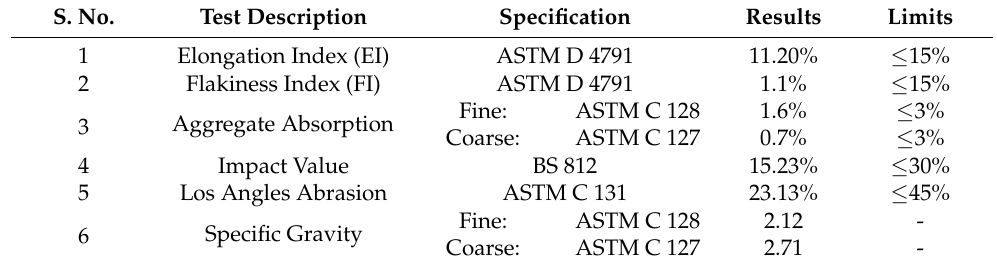
Table 4. Properties of aggregate.